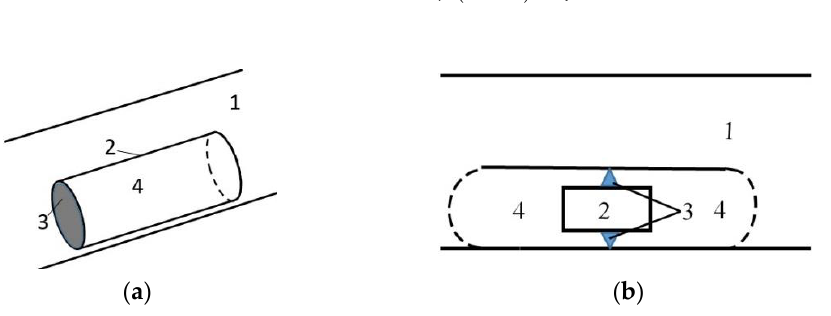
Figure 2. ( a ) Initial model of the dipole resonator [10]: 1 — waveguide; 2 — cylinder; 3 — tightened membrane; 4 — medium inside cylinder. ( b ) Calculation model of a dipole resonator in a waveguide: 1 — waveguide; 2 — the mass of the dipole; 3 — the springs of the dipole; 4 — the medium filling the dipole — its attached mass.